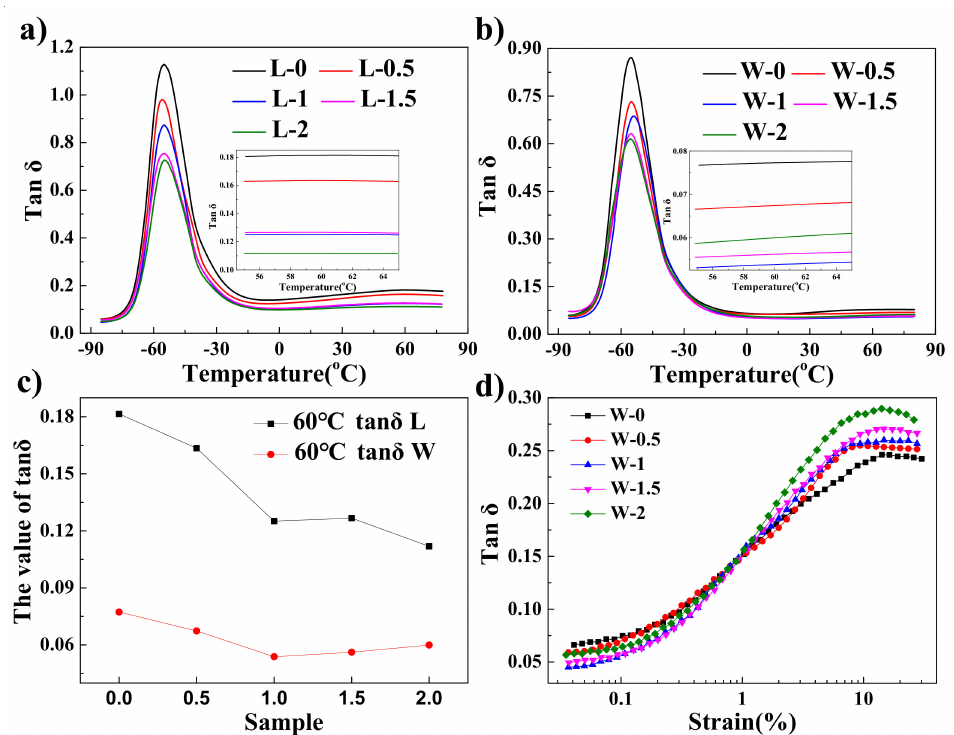
Figure 8. The dynamic properties of the di ff erent rGO / 60SiO 2 / NR composites with di ff erent rGO contents. ( a ) Loss factor of the composites made by the LMTM method. ( b ) Loss factor of the composites made by the WCL method. ( c ) Loss factor of di ff erent composites at 60 ◦ C made by the WCL method and LMCM method. ( d ) Loss factor of the composites made by the WCL method with di ff erent strains at 60 ◦